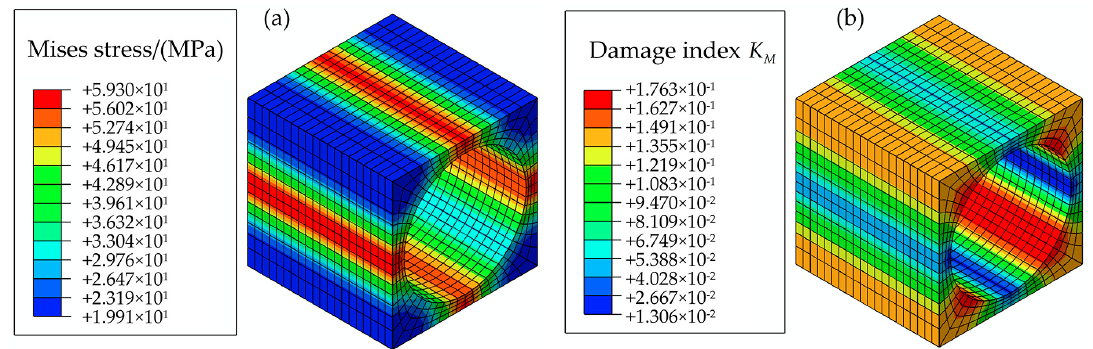
Figure 7. Distributions of Mises stress and damage index in the matrix caused by thermal residual stress: ( a ) Mises stress; ( b ) Damage index.